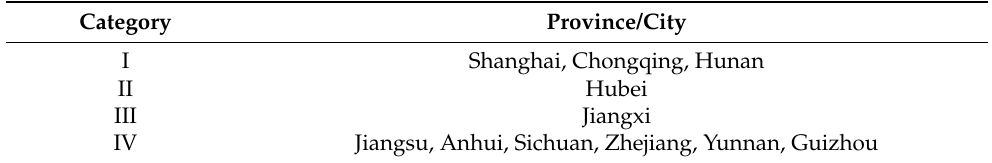
Table 7. Four categories of